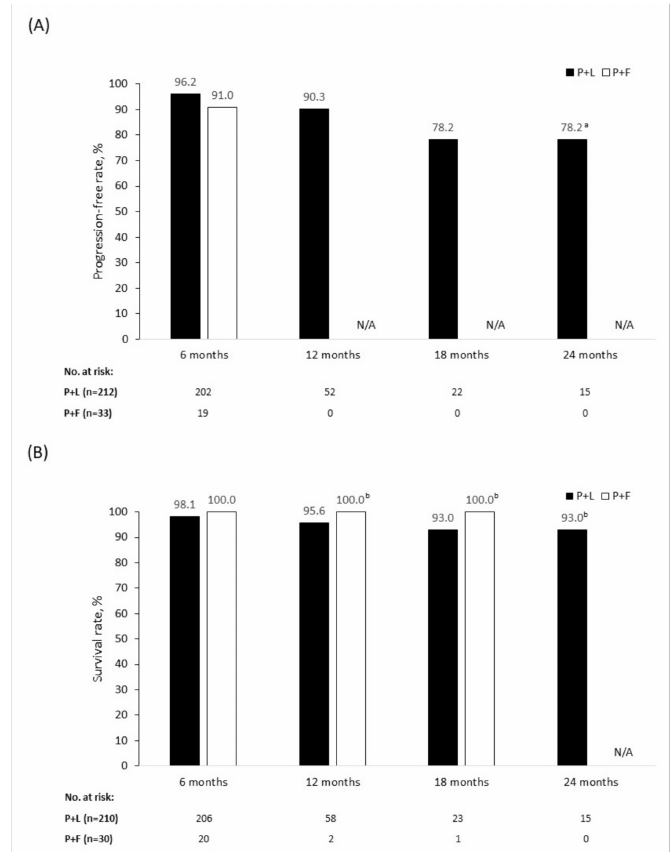
Figure 1. Progression-free rate ( A ) and survival rate ( B ) in patients treated with palbociclib +